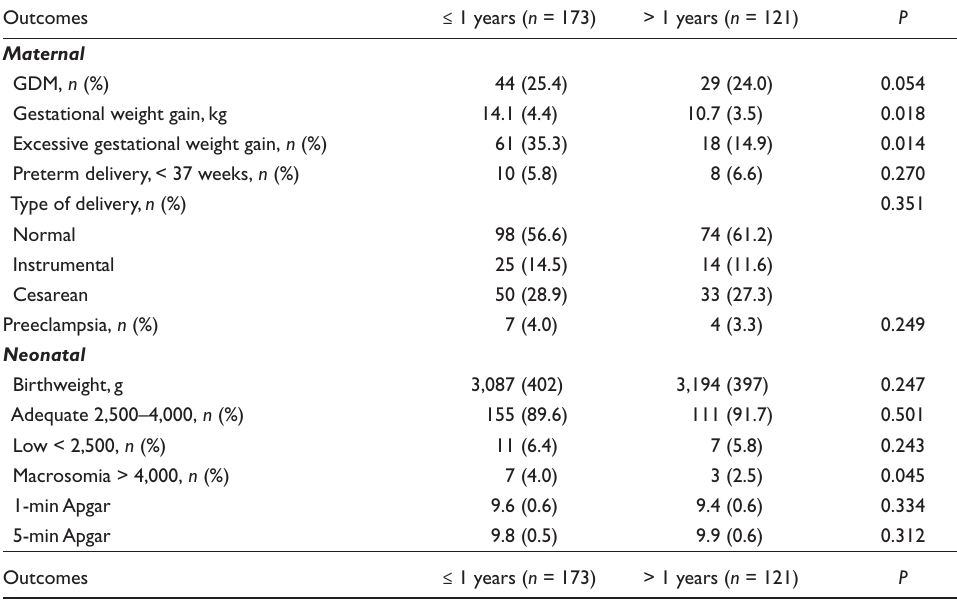
Table 5. The occurrence of GDM and pregnancy outcomes